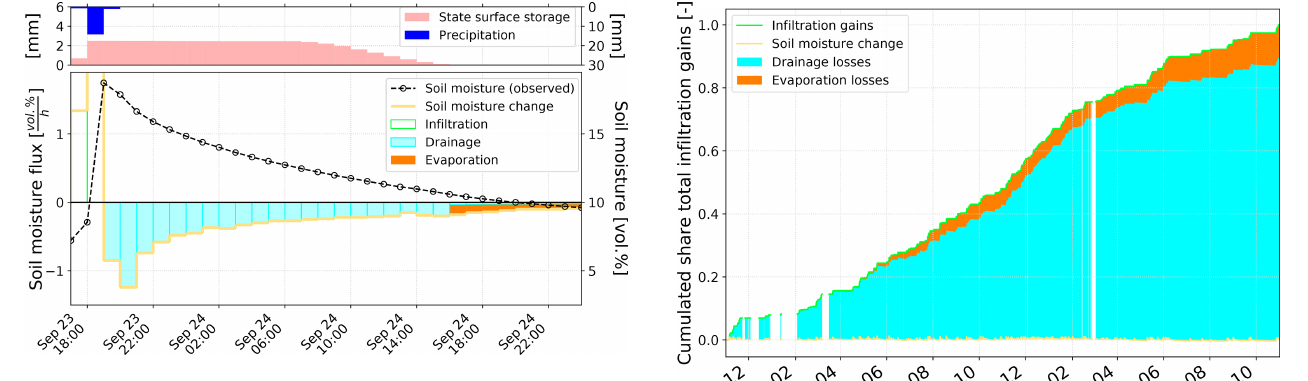
Figure 7. Closure of the soil water balance from measured d θ/ d t and predicted drainage loss for plot CP14 over a period of 30h.